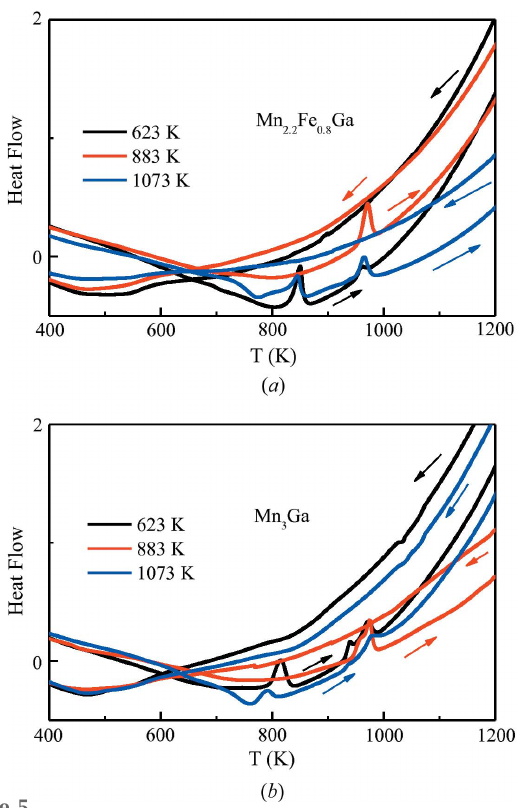
Figure 5 DSC measurements for ( a ) Mn 2.2 Fe 0.8 Ga and ( b ) Mn 3 Ga treated at different temperatures.